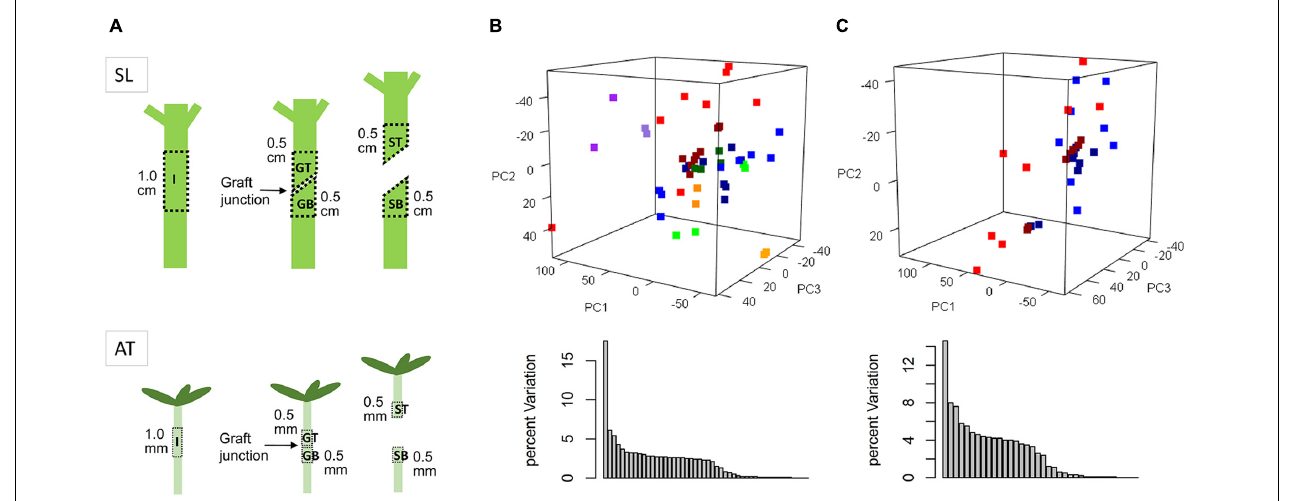
FIGURE 1 | Diagram of sampling regions (A) and principle component analysis (PCA) of transcriptomic variation of all samples (B) or GT and GB samples only (C) . SL and AT are short for Solanum lycopesicum and Arabidopsis thaliana , respectively. I, GT, GB, ST, and SB represent sample types of intact, grafted top, grafted bottom, separated top, and separated bottom. Red dots, GT_AT; blue, GB_AT; purple, ST_AT; orange, SB_AT; green, I_AT; dark red, GT_SL; dark blue, GB_SL; dark purple, ST_SL; dark orange, SB_SL; dark green,